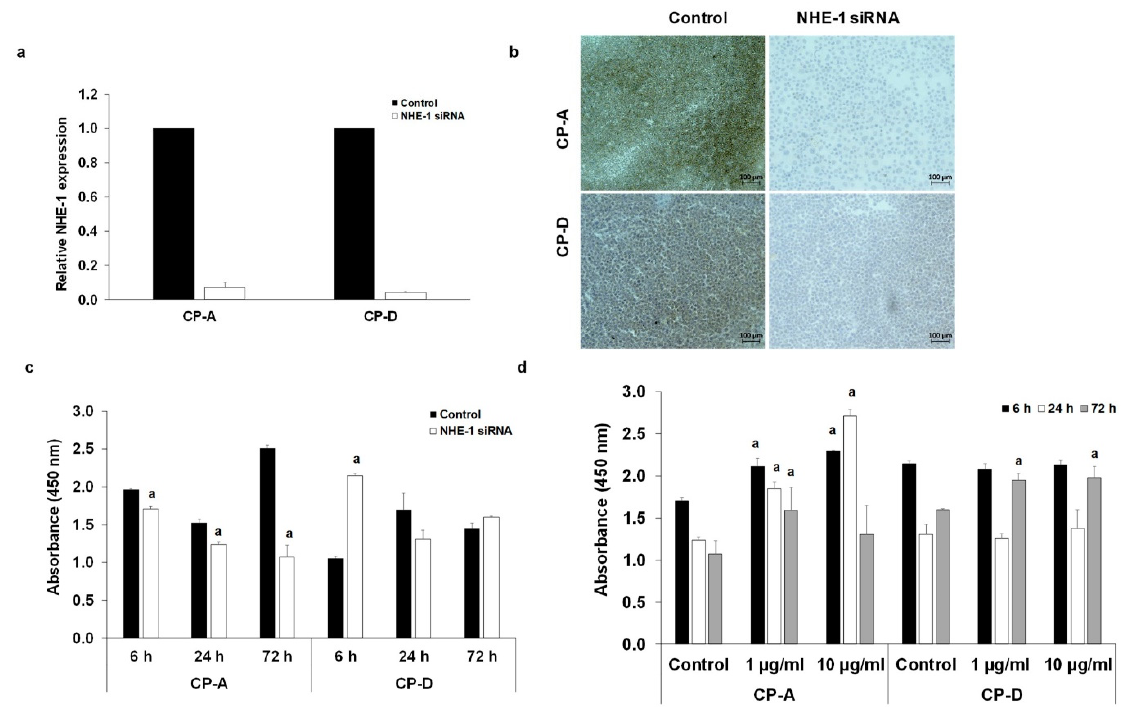
Figure 7. Knockdown of Na + /H + exchanger-1 (NHE-1) in human esophageal cell lines. The expression levels of NHE-1 were investigated by RT-PCR ( a ) and immunohistochemistry ( b ) in control cells and in cells treated with specific siRNA for SLC9A1 . The rate of proliferation was determined in the non-treated ( c ) and cigarette smoke extract-treated ( d ) CP-A and CP-D cells. Data represent mean ± SEM of three independent experiments; a = p ≤ 0.05 vs. control.